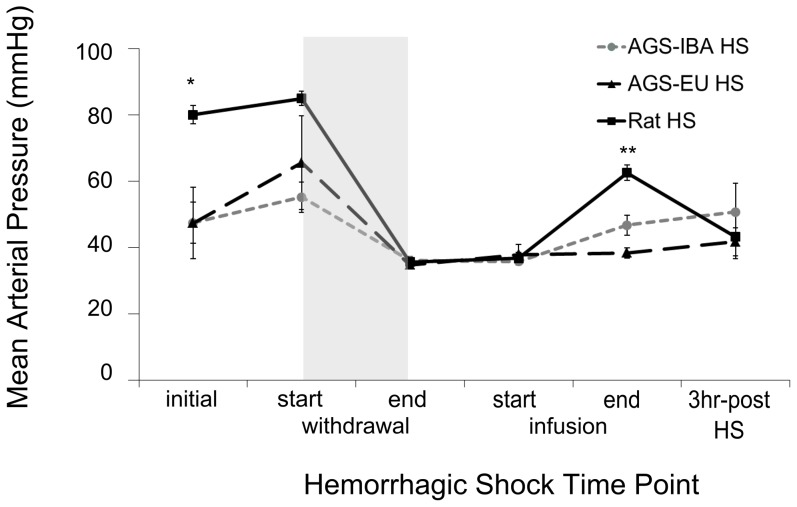
Mean arterial pressure during hemorrhagic shock.Mean arterial pressure decreases to the same mmHg for all groups during HS and is restored to varying degrees with Ringers reperfusion. Shaded region indicates period of hemorrhage. * Tukey, p<0.05 between rats and both EU- and IBA-AGS, ** Tukey, p<0.05 between all groups. Data shown as mean±SEM, n = 6–7 for all groups.